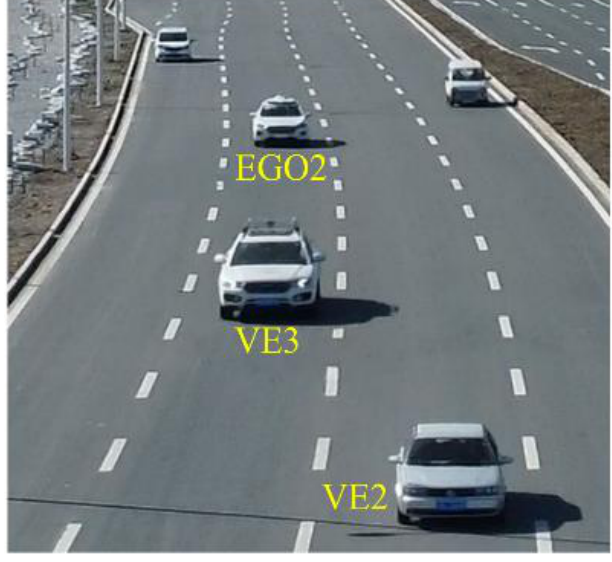
Figure 14. Actual vehicle verification scenario.